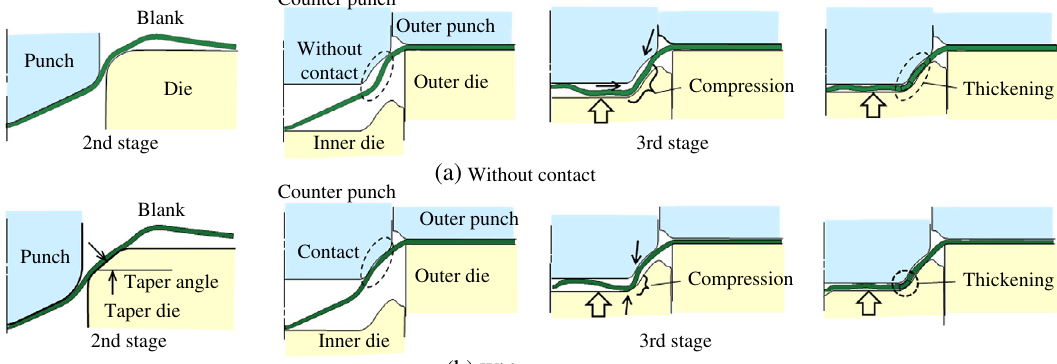
Figure 7. Improvement of thickening of two corners by contact of inclined portion between two corners: (a) without contact and (b) with contact in thickening of 3rd stage.